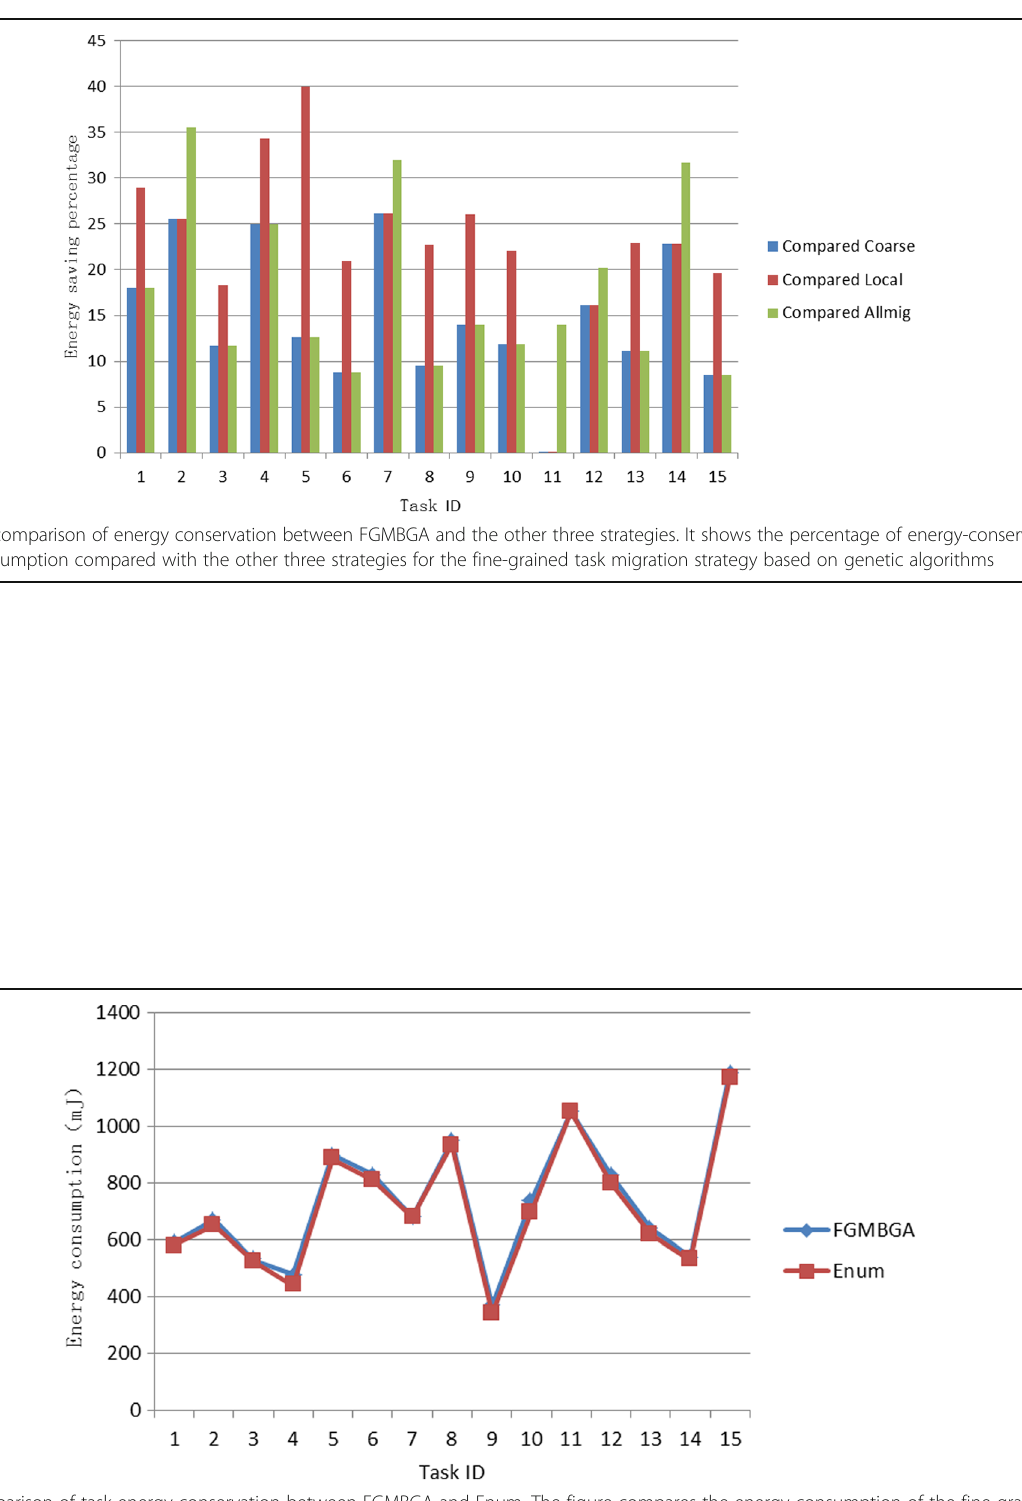
Fig. 7 Comparison of task energy conservation between FGMBGA and Enum. The figure compares the energy consumption of the fine-grained task migration strategy (FGMBGA) and the exhaustive method (Enum) based on the genetic algorithm. It can be observed that the line graphs of the Enum and FGMBGA algorithms basically overlap. Although the FGMBGA strategy does not traverse the entire solution space, the results obtained by the optimal solution and the exhaustive method are almost the same, which proves that the algorithm can reduce the time complexity and also ensure the